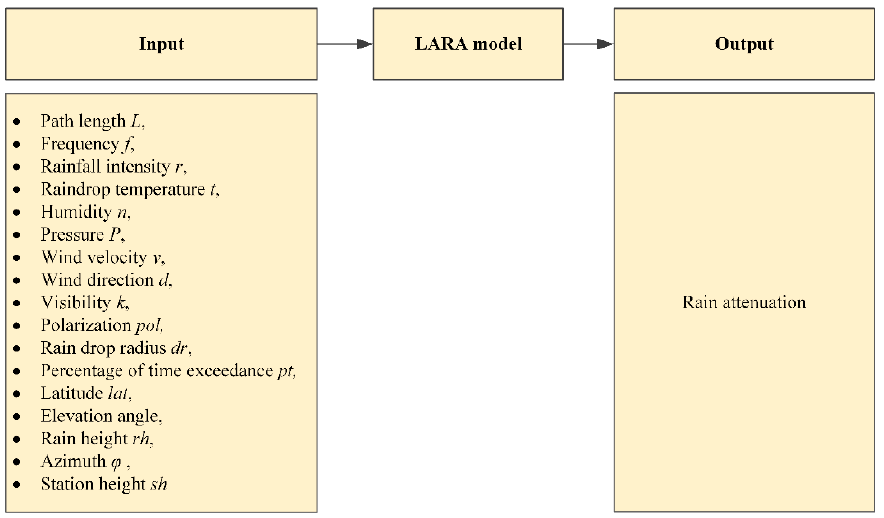
Figure 2. A general illustration of the LARA model’s input and output parameters. Table 1. Learning algorithms used in currently published rain attenuation model. Ref.